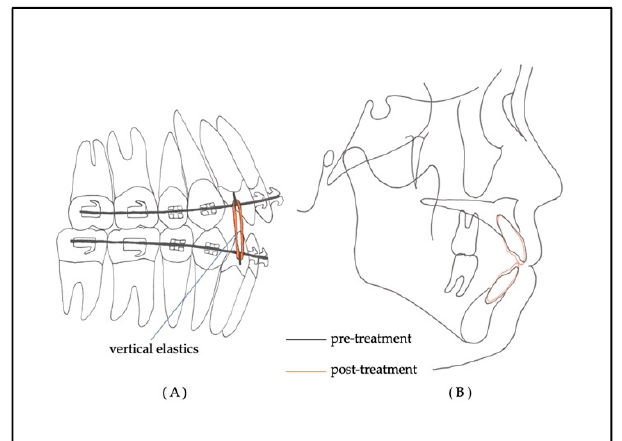
Figure 2. ( A ) A schema of orthodontic treatment of open bite with extruding anterior teeth using a multi-bracket appliance system and vertical elastics. ( B ) Superimposition of cephalometric trace pre- and post-treatment.